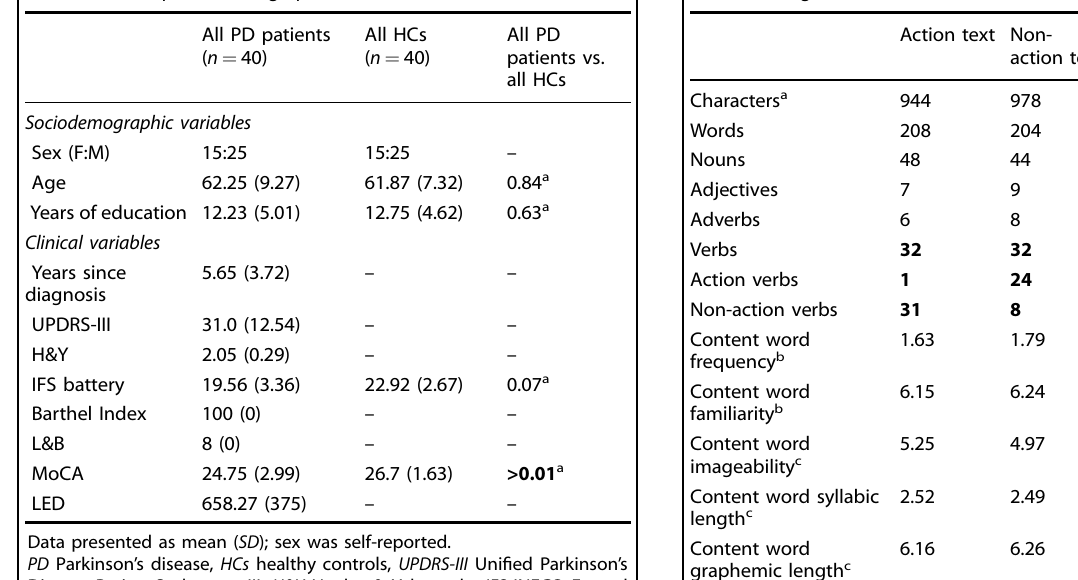
Table 5. Participants ’ demographic and clinical data. Table 6. Linguistic features of the